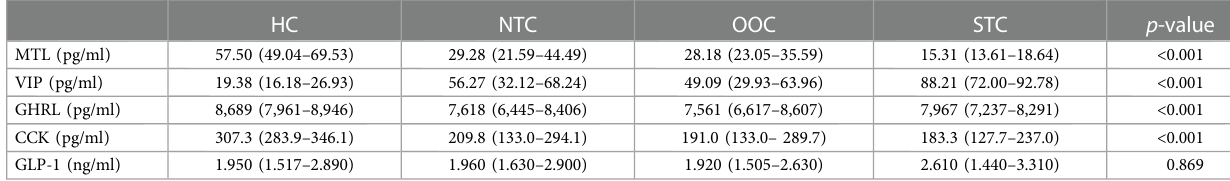
TABLE 3 Serum concentration of gastrointestinal motility-related